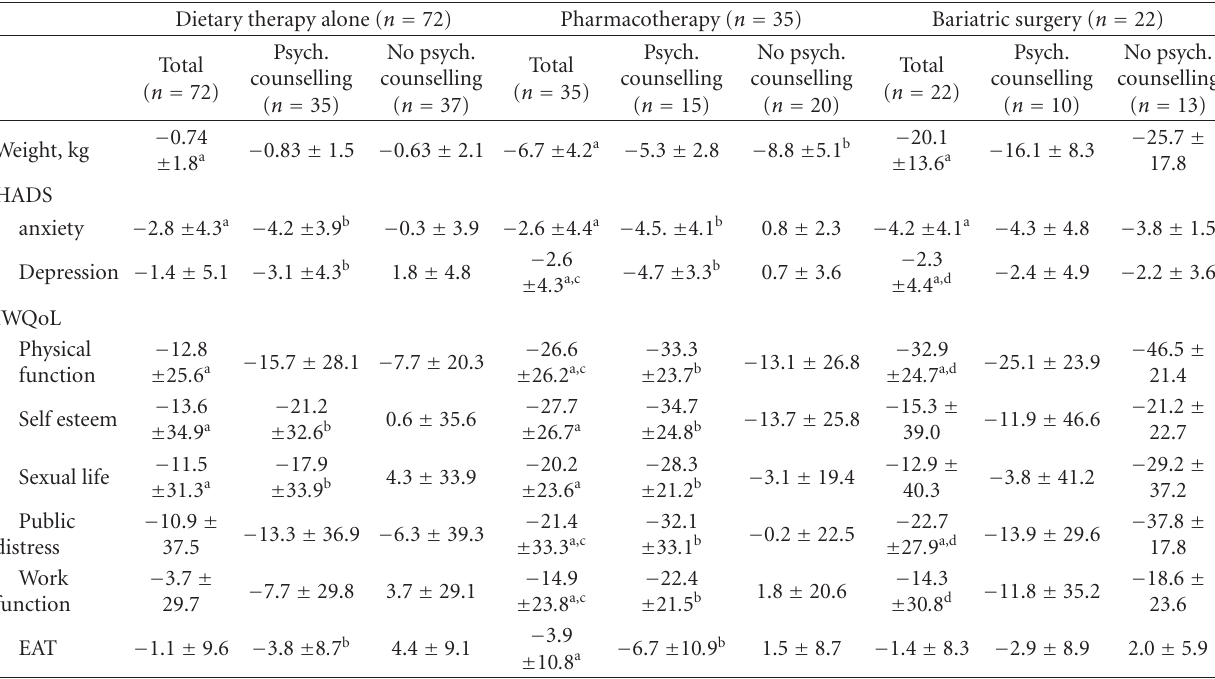
Table 2: Follow-up changes (mean ±